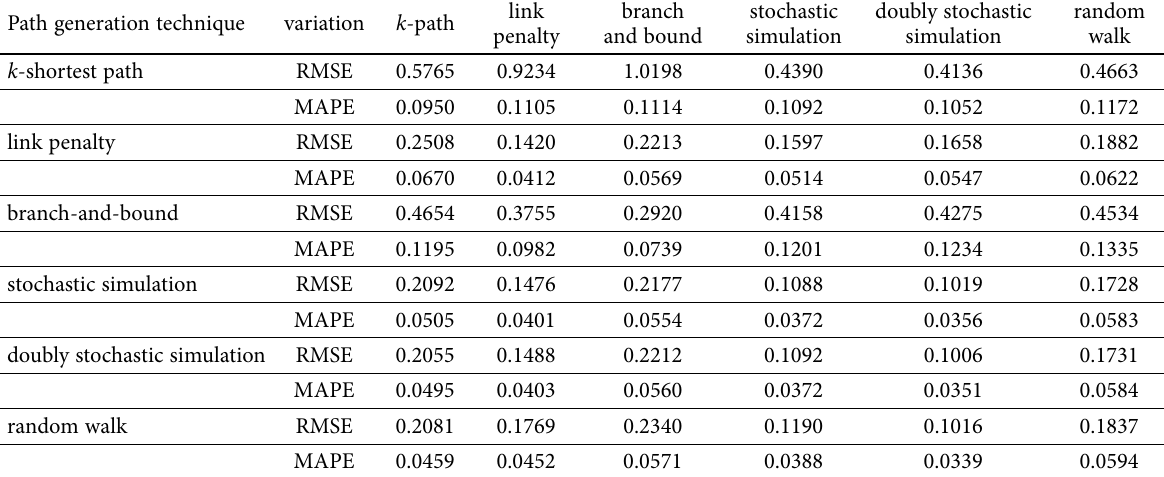
Table 8. Prediction errors of generated choice sets with respect to postulated choice